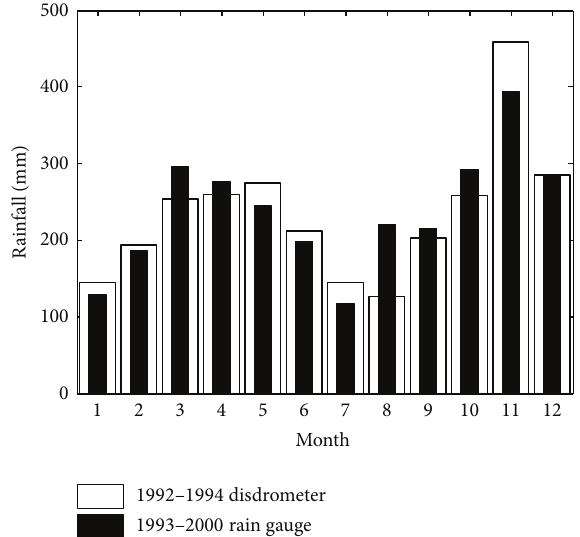
Figure 2: CCDF of rainfall rate from different climatology regions: Kuala Lumpur (1992–1994) equatorial, Miami (40 Year) subtropical, and Spino d’Adda (1994–2000) temperate.